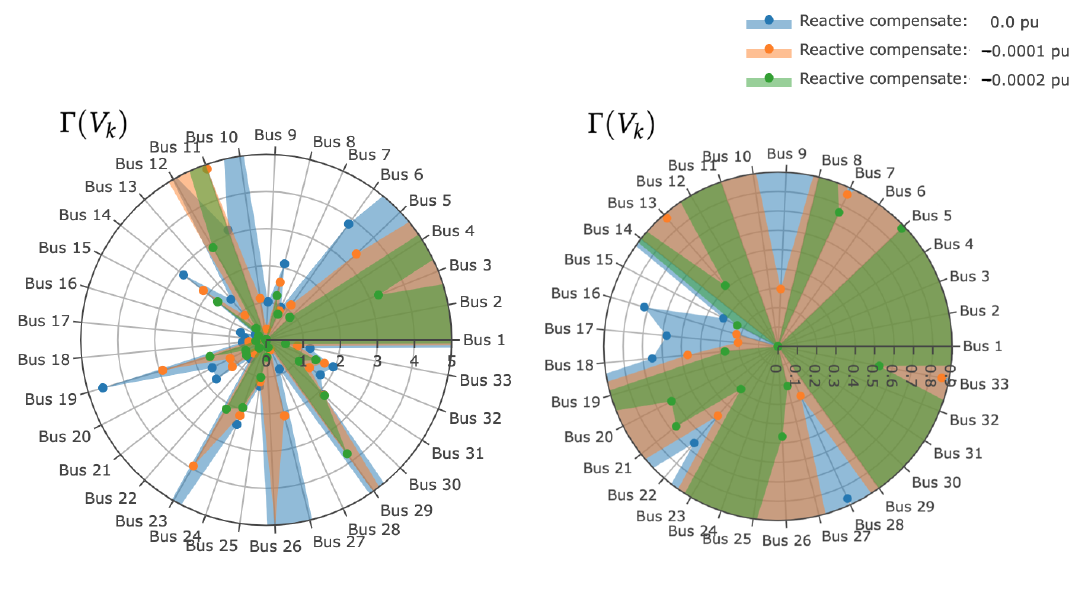
Figure 3. The variation of Γ indicating voltage collapse risk on IEEE 33-bus test distribution